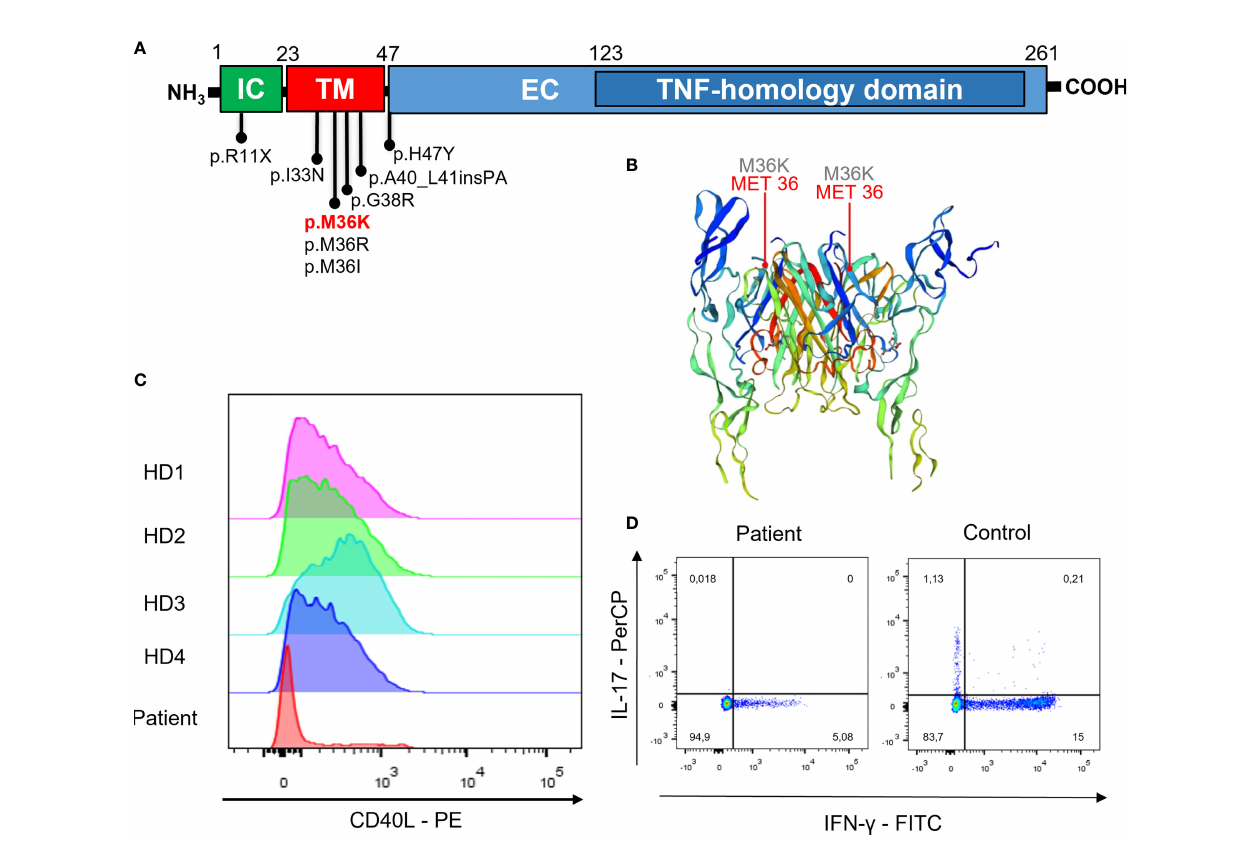
FIGURE 2 | Gene model, CD40L expression, and cytokine production. (A) Localization of variants associated to atypical phenotypes and in the transmembrane domain. (B) Crystal structure of CD40L (P25942) from https://swissmodel.expasy.org/repository/uniprot/P25942?template=3qd6. (C) CD40L expression after polyclonal stimulation (histogram plots show cells gated on CD3+CD4+ T cells from PBMNCs) in the patient and in four different healthy donors (HD). (D) IFN- g and IL-17 intracellular staining after polyclonal stimulation in the patient and a representative control (dot plots show cells gated on CD3+CD4+ lymphocytes from